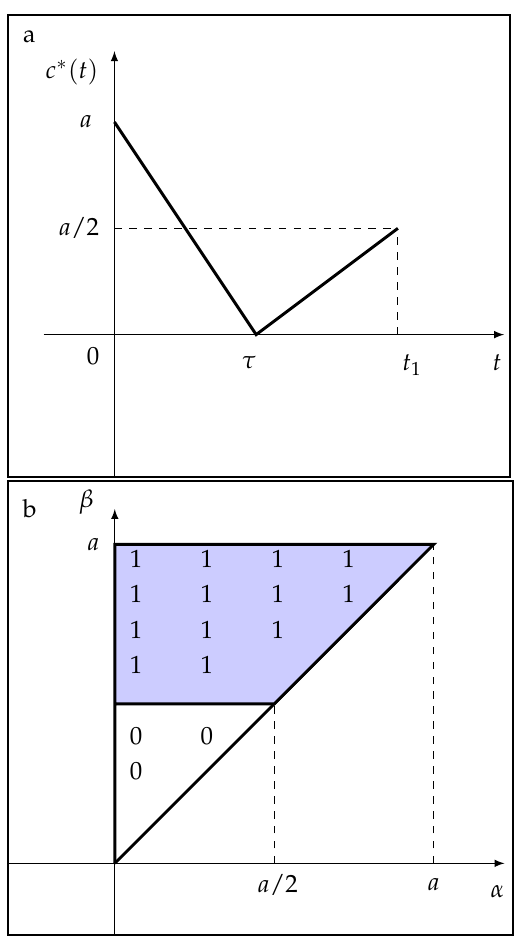
Figure 3. ( a ) The graph of the function c ∗ ( t ) , demonstrating the profit maximisation c ( t ) P ( t ) at the moment t 1 > 0; ( b ) The state of the Preisach operator at the moment t = t 1 . The region of the plane ( α , β ) , where the elementary relays are on, is filled with